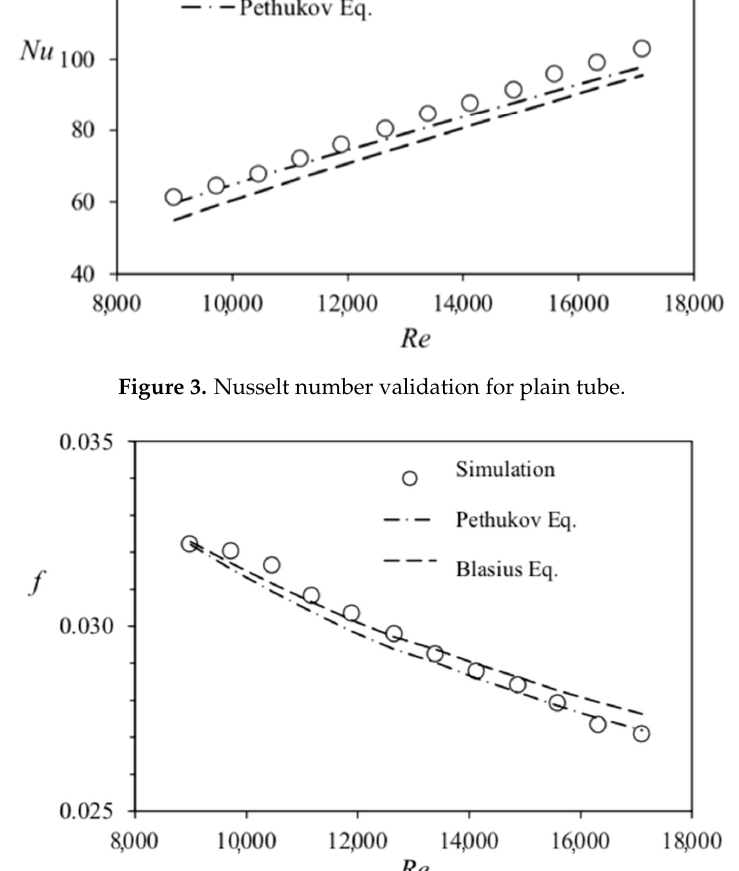
Figure 4. Friction factor validation for plain tube.